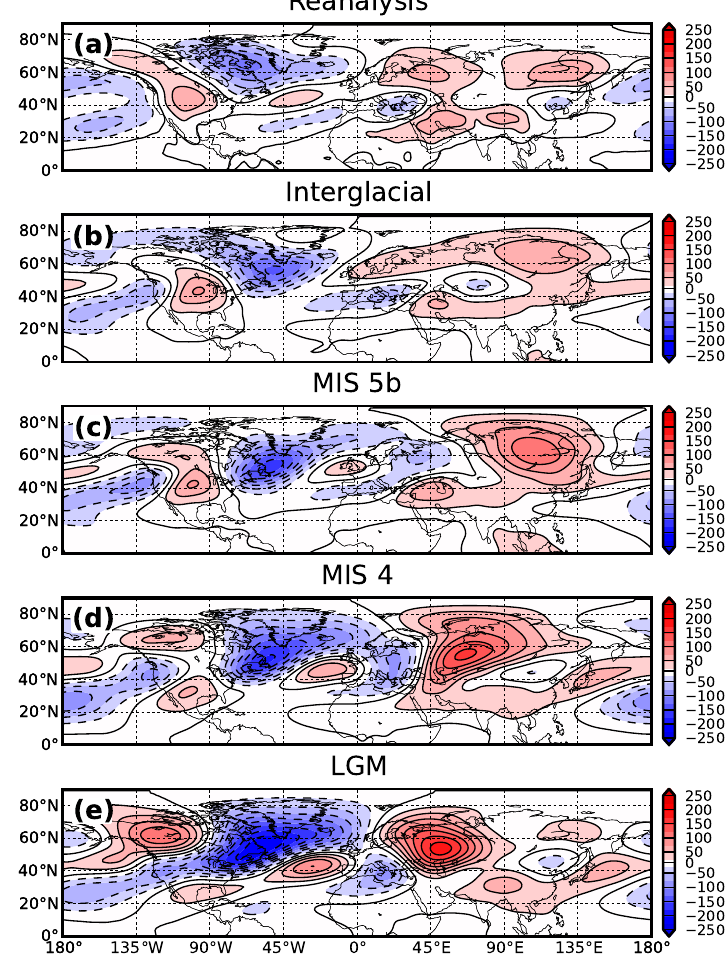
Figure 5. Evolution of the 300hPa eddy geopotential in the summer (JJA) season. The contour interval is 25m.